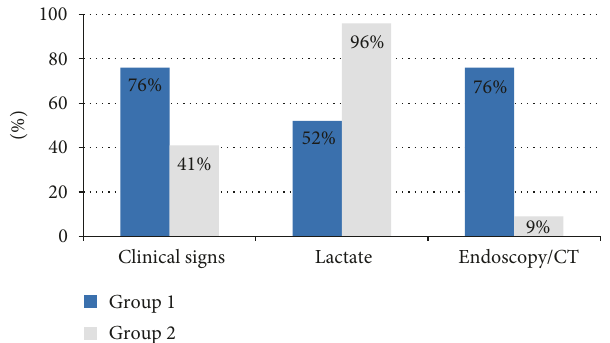
Figure 1: Hyperlactatemia was the most frequent reason for study inclusion in group 2, whereas patients of group 1 frequently had signs of bowel ischemia in endoscopy or CT in addition to clinical suspicion. Only 52% of group 1 had elevated serum lactate levels compared to 96% in group 2.